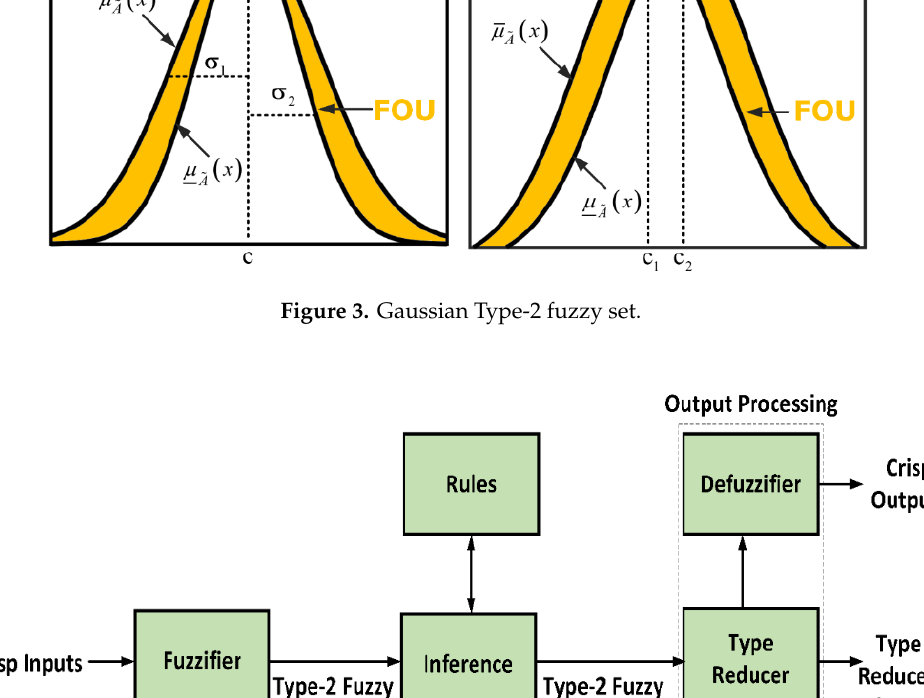
Figure 3. Gaussian Type-2 fuzzy set.